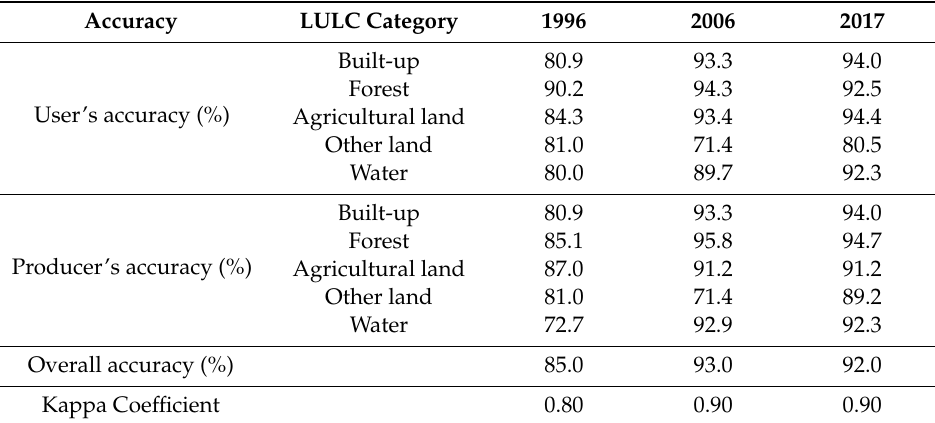
Table 4. Accuracy assessments of the LULC